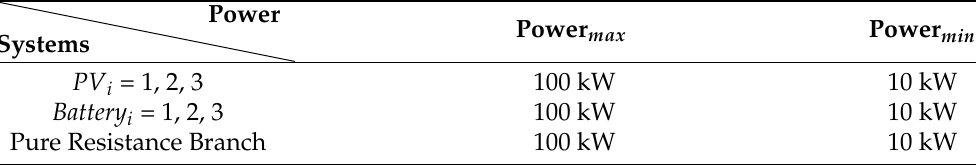
Table 6. Loading condition for the seven-bus mesh system.